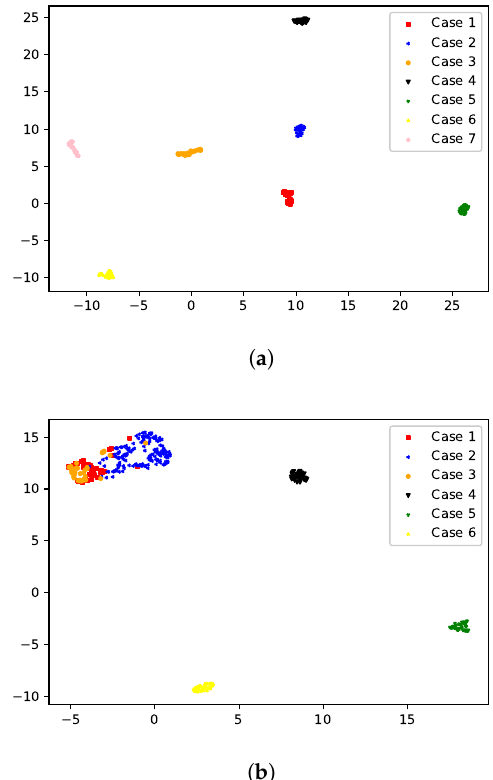
Figure 11. Low-dimensional representation of all classes classification for both datasets: ( a ) Dataset 1: low-dimensional representation of all cases; ( b ) Dataset 2: low-dimensional representation of all